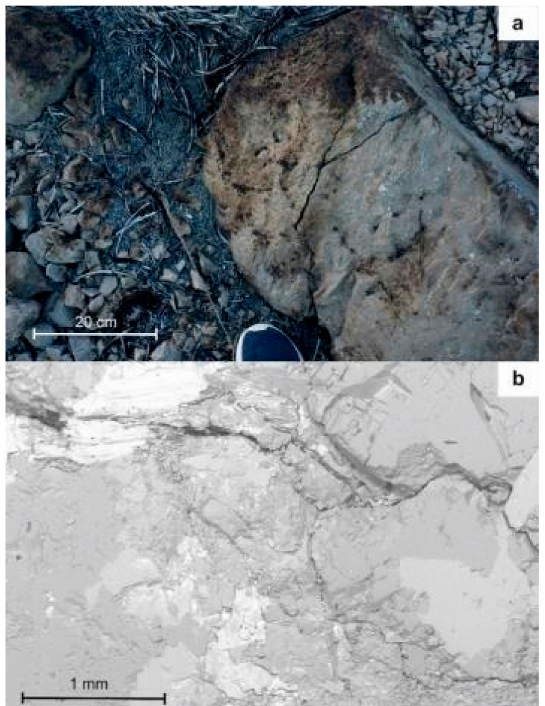
Figure 3. ( a ) Fractures appearing on a limestone boulder (35 cm across) affected by a forest fire in the Foncalent mountain range located on a dry arid region of Alicante, SE Spain, with a low thermal load. ( b ) Scanning electron microscope image of microcracks affecting a granite specimen from near Vila Real, N Portugal heated in the laboratory up to 600 ◦ C and cooled by immersion in water in the Laboratory of Rock Mechanics of the University of Alicante.